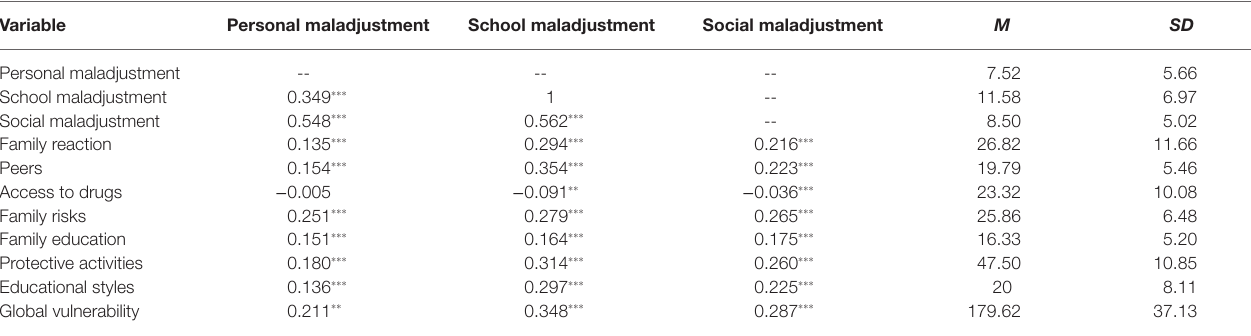
TABLE 2 | Descriptive statistics and bivariate correlations between the FRIDA and the TAMAI subscales. Variable